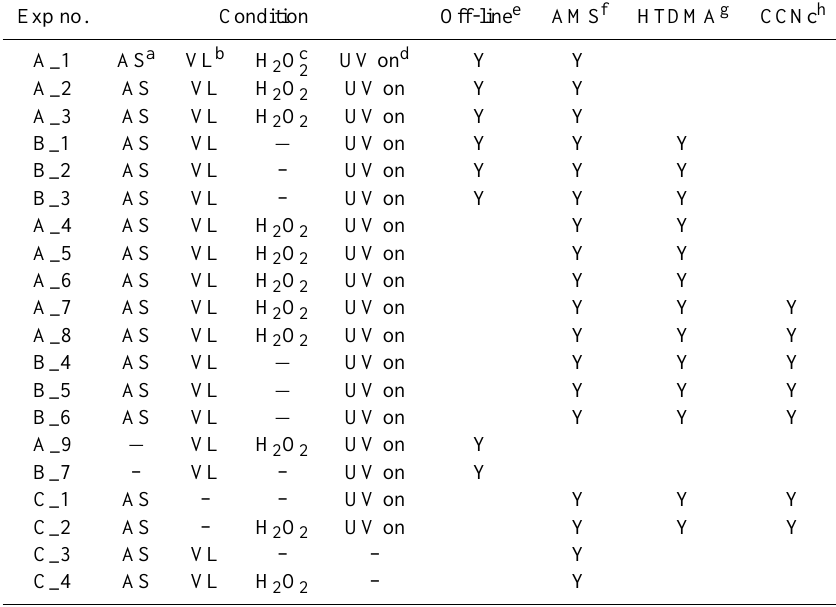
Table 1. Summary of experimental conditions and measurements. Exp no. Condition Off-line e AMS f HTDMA g CCNc